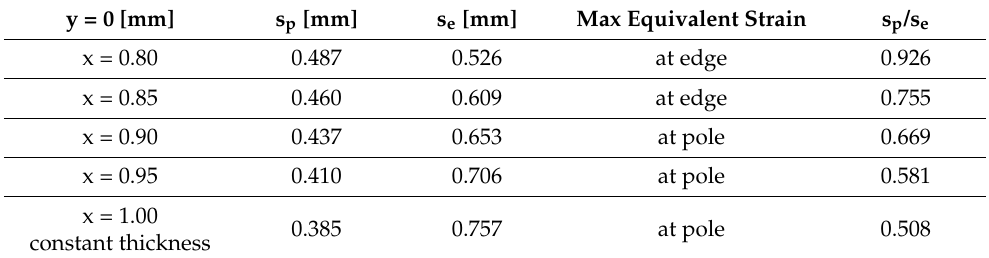
Table 3. FEM optimization analysis for different values of x